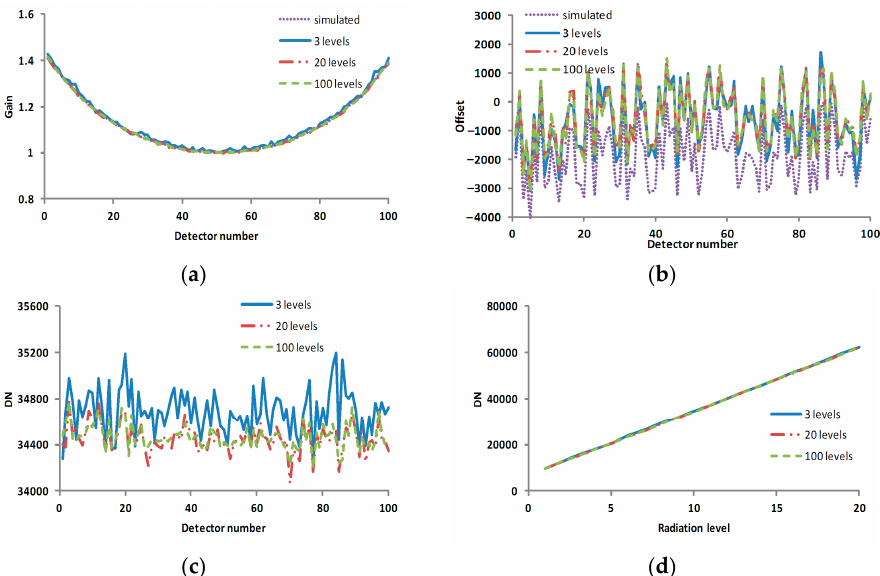
Figure 12. The profiles of the calibration coefficients and corrected results in the various scenarios of Case 2. ( a ) the gain coefficient in various scenarios; ( b ) the offset coefficient in various scenarios; ( c ) the profile of line 10 in the corrected result corresponding to Figure 11; and ( d ) the profile of column 50 in the corrected result corresponding to Figure 11. The horizontal axes of ( a – c ) are pixel number, and the vertical axes of ( a – c ) are the gain coefficient, offset coefficient and DN, respectively. The horizontal axis and vertical axis of ( d ) are radiation level and DN, respectively.